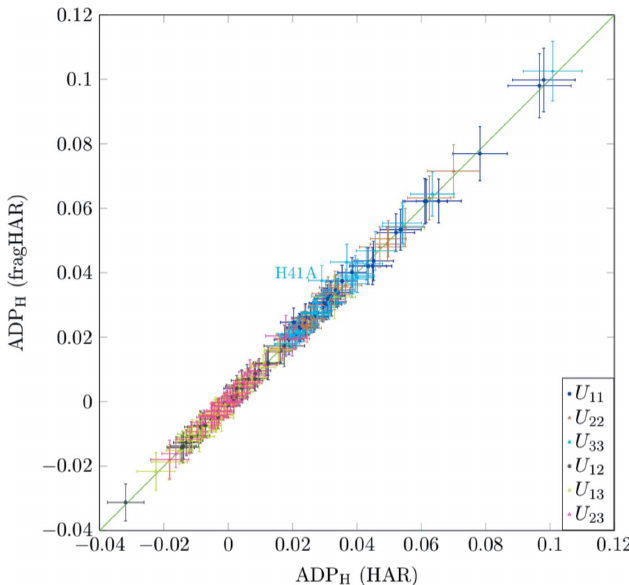
Figure 6 Hydrogen ADPs (with error bars) obtained with fragHAR versus those from HAR for the A 4 P 2 system. The hydrogen-bonded H41A atom is labelled.